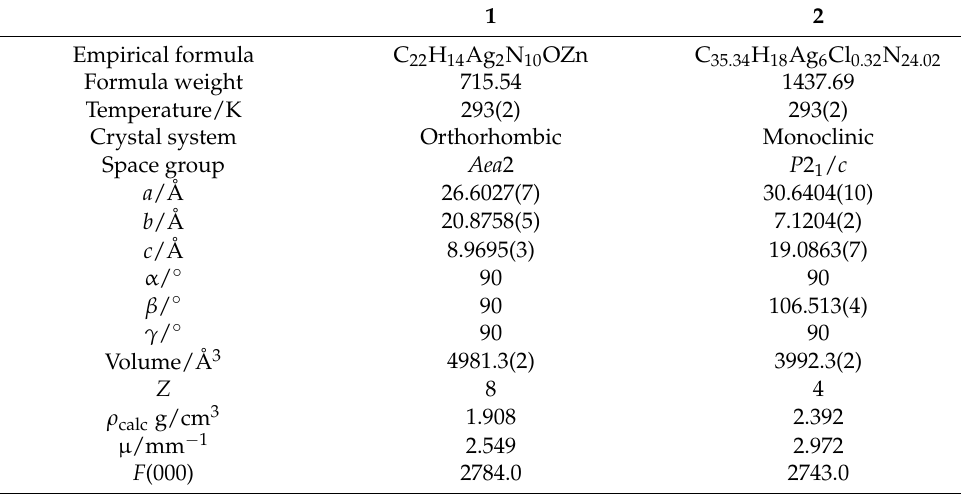
Table 1. Crystal data and structure refinement for 1 and 2